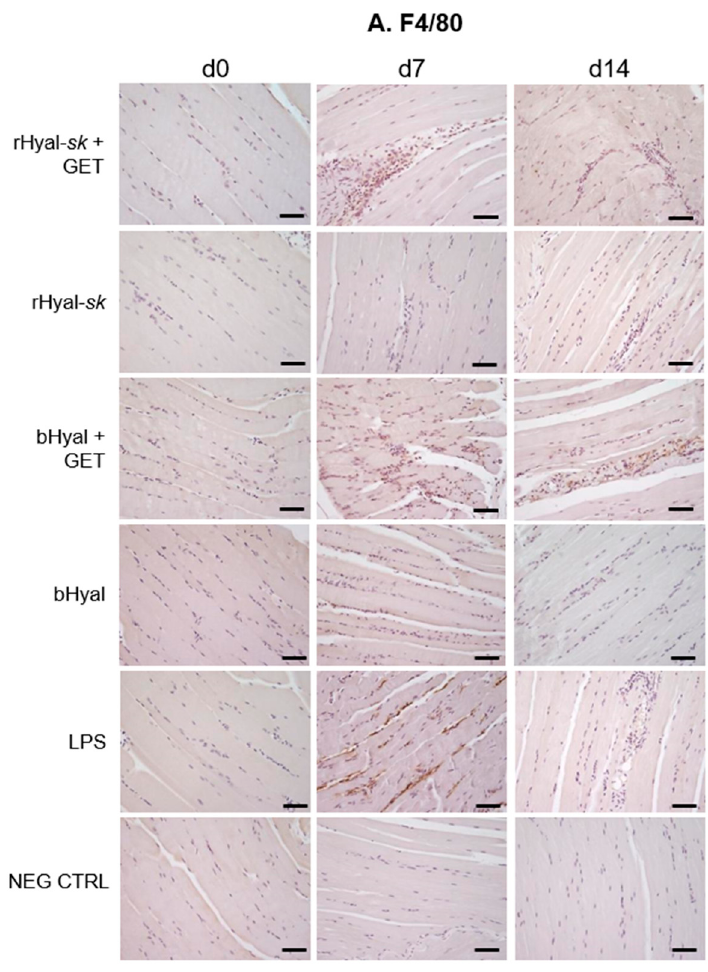
Figure 3. Figure 3 . Cont.